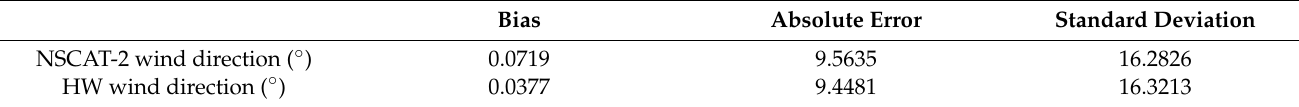
Table 5. The errors of HW-GMF and NSCAT-2 GMF wind direction statistical